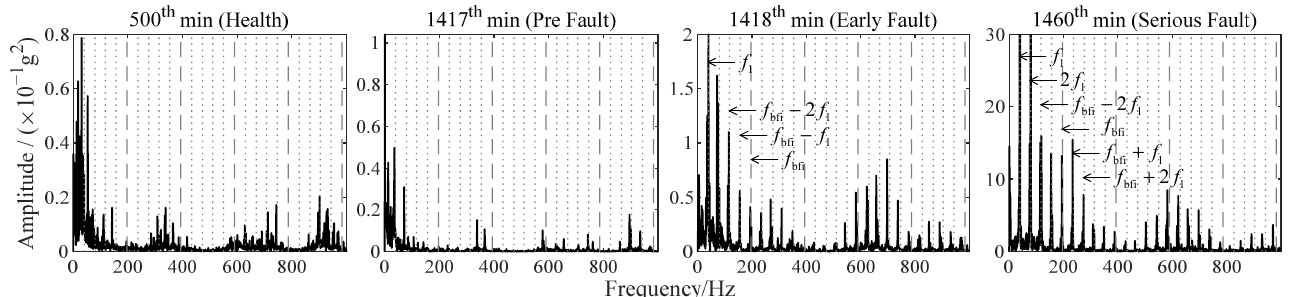
Figure 15. Fourier spectra obtained with improved TKEO for vibration signals in Figure 14b.